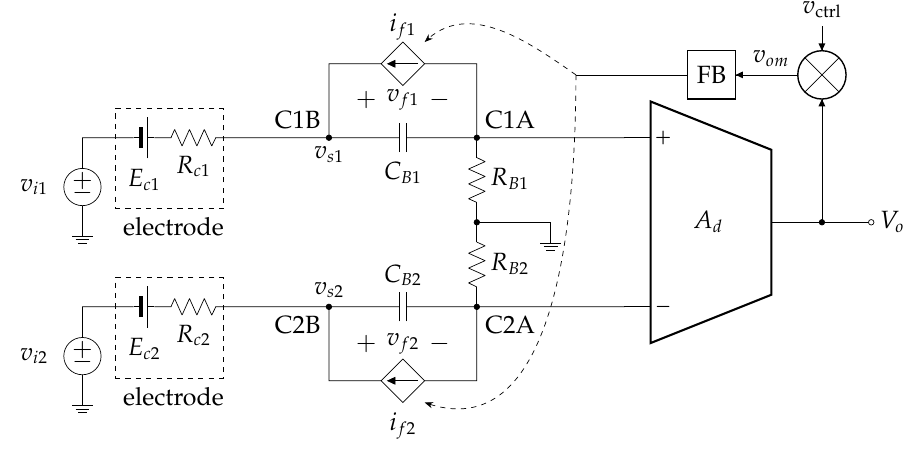
Figure 2. Controlling the feedback loop (with a variable-gain amplifier or a multiplier) enables an external controlling voltage: ( a ) the basic circuit; ( b ) the results of the LT-SPICE simulation with G m = 80µ Ω − 1 , k v = 1V − 1 , A v = 50V/V, C B = 10µF, R B = 160k Ω , E c = 0V, R c = 5k Ω , over several values of the controlling voltage.